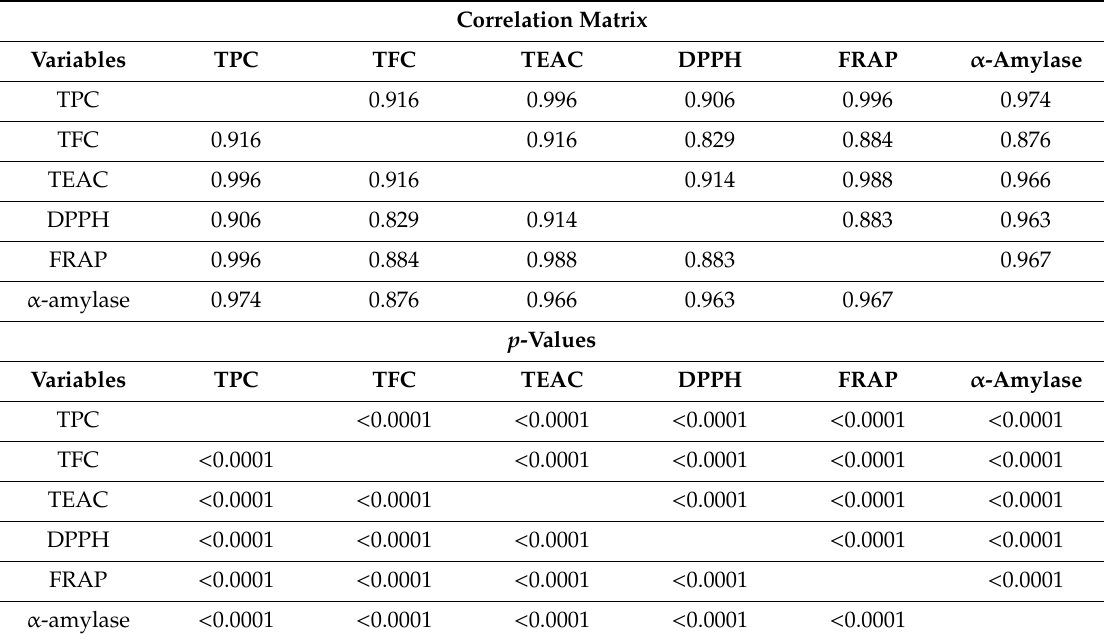
Table 3. Pearson correlation and corresponding p -values among variables.